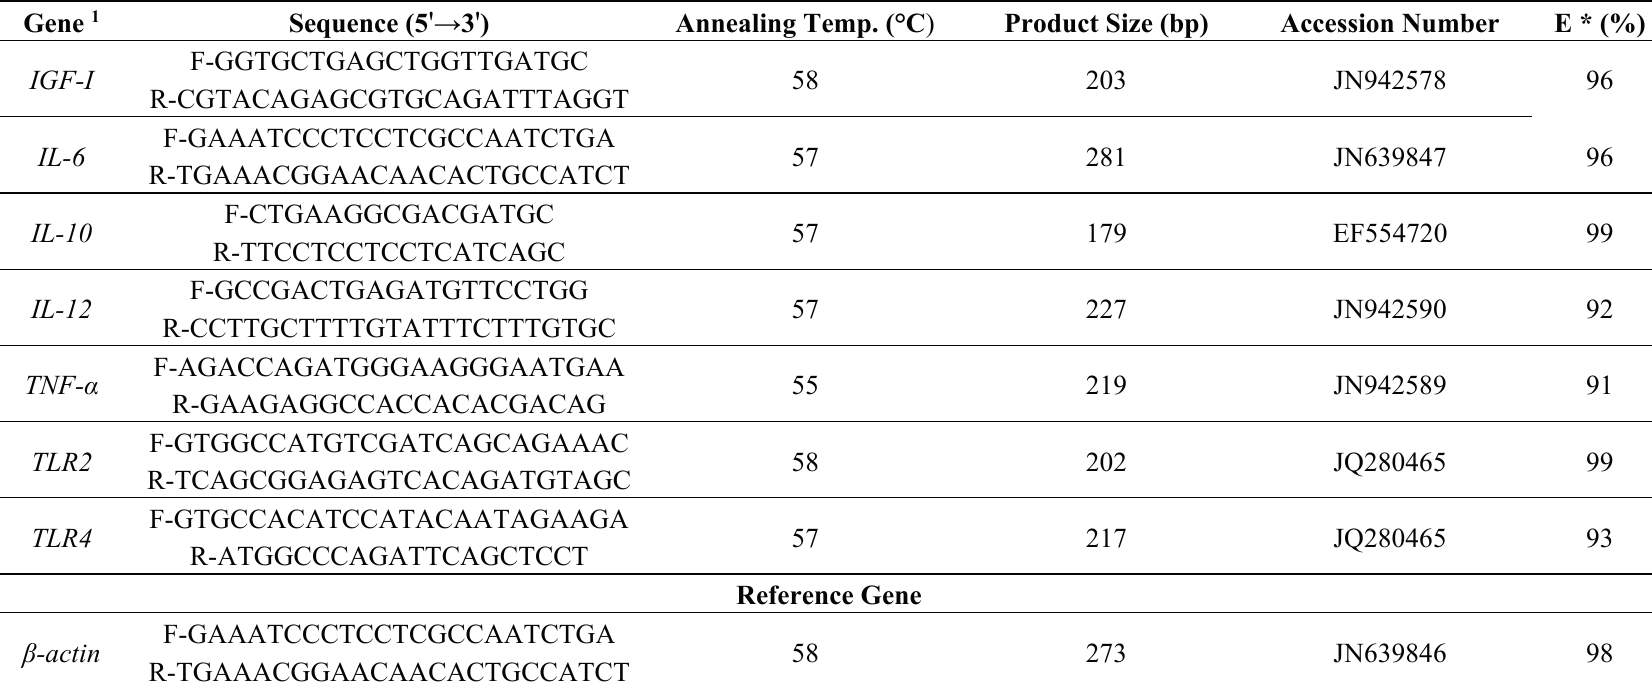
Table 4. Oligonucleotide sequence of growth- and immune-related gene